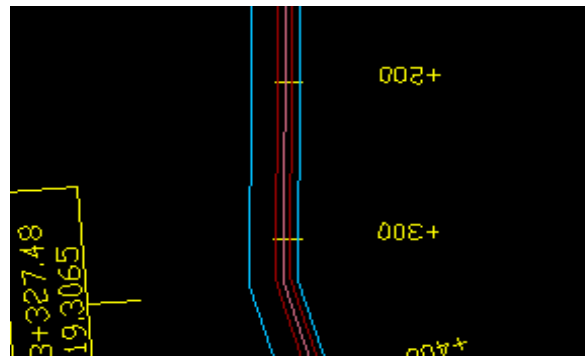
Figure4. 1:5.000 Scaled Pipeline Layouts